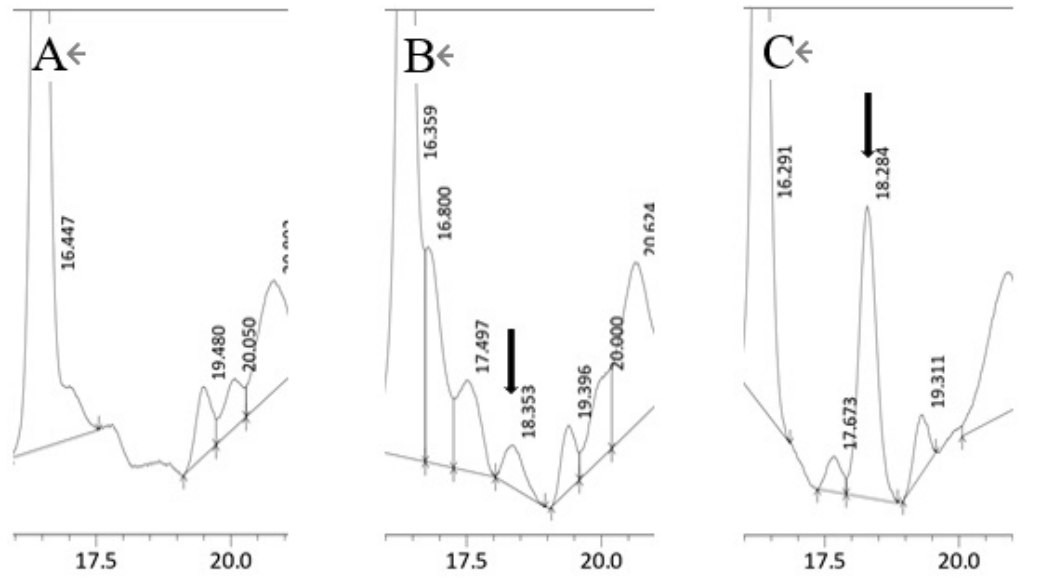
Figure 7. HPLC chromatograph of the fibroblast culture medium. (A) Cultured medium without Ara, (B) Cultured medium containing 75 μM of Ara. (C) Cultured medium spiked with a 12-KETE standard (1.53 ng). Black arrows show 12-KETE peaks. Replications (n = 3) of experiments showed the same results. HPLC, high performance liquid chromatography; Ara, eicosatetraenoic acid; 12-KETE, 12-oxo-5Z,8Z,10E,14Z-eicosatetraenoic